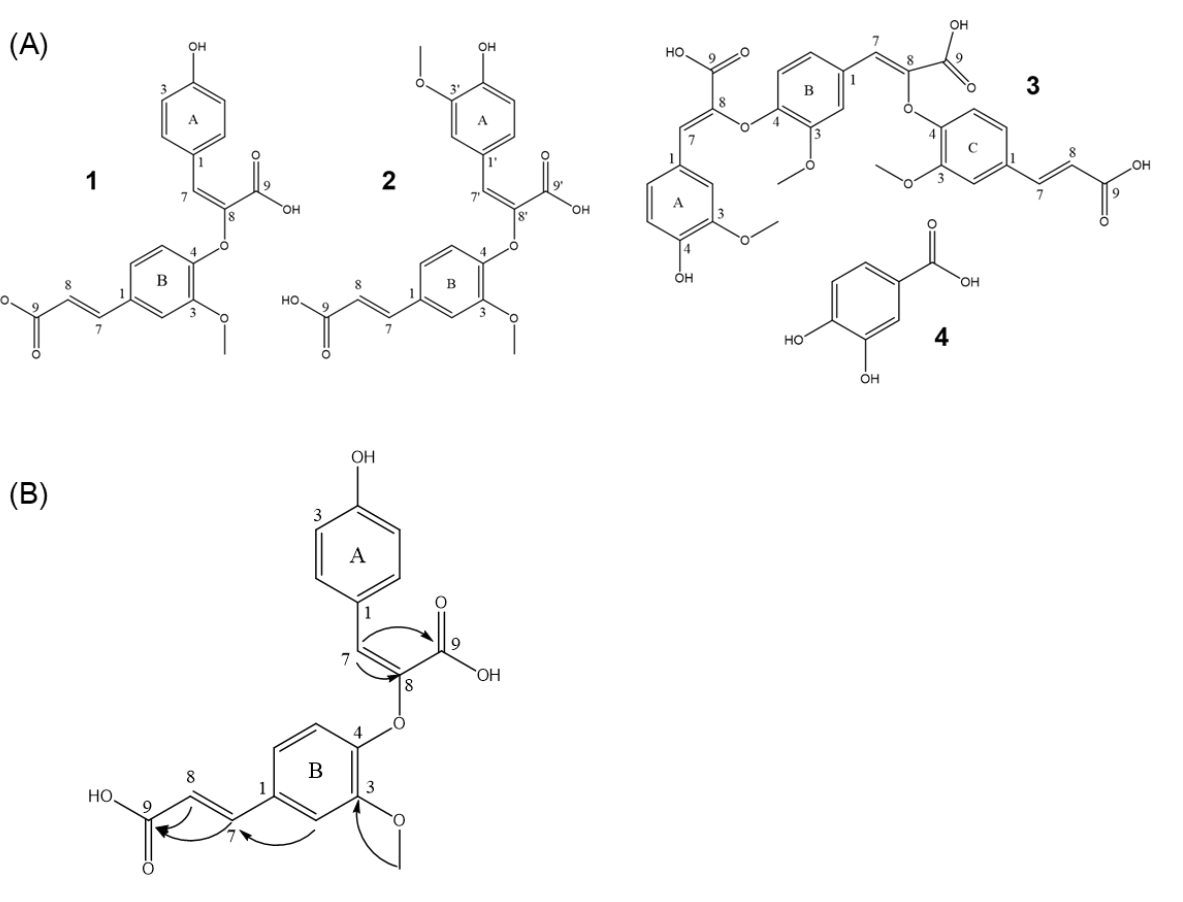
Figure 9. ( A ) Structures of isolated compounds ( 1 – 4 ). ( B ) Key HMBC correlations for compound 1 (from proton to carbon).